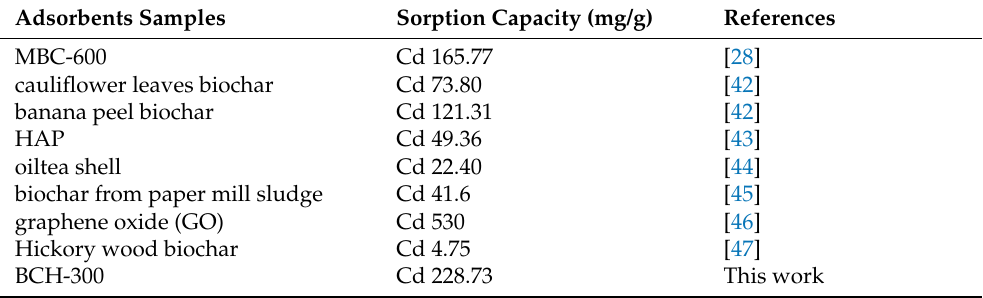
Table 1. Compared of cadmium sorption capacity of BCH-300 with other adsorbents. Adsorbents Samples